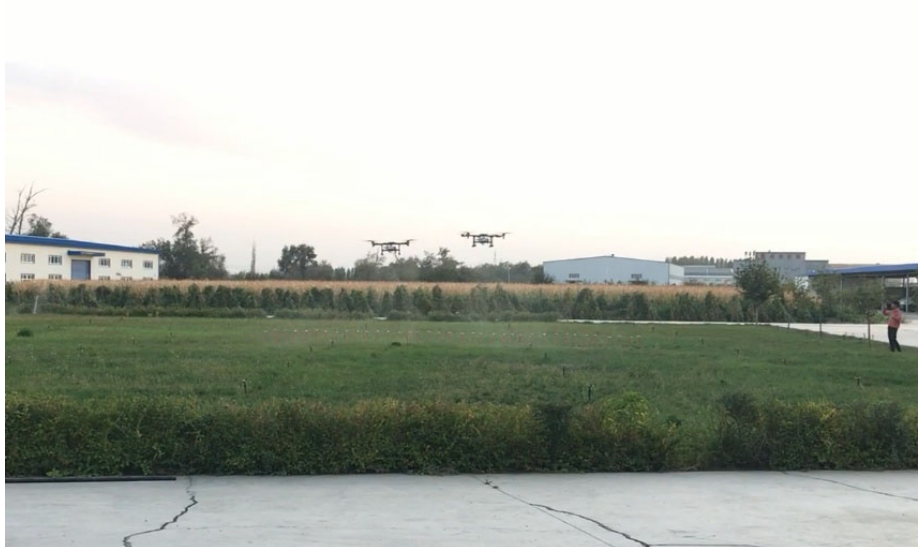
Figure 13. Front view of dual ‐ UAV simultaneous spraying.